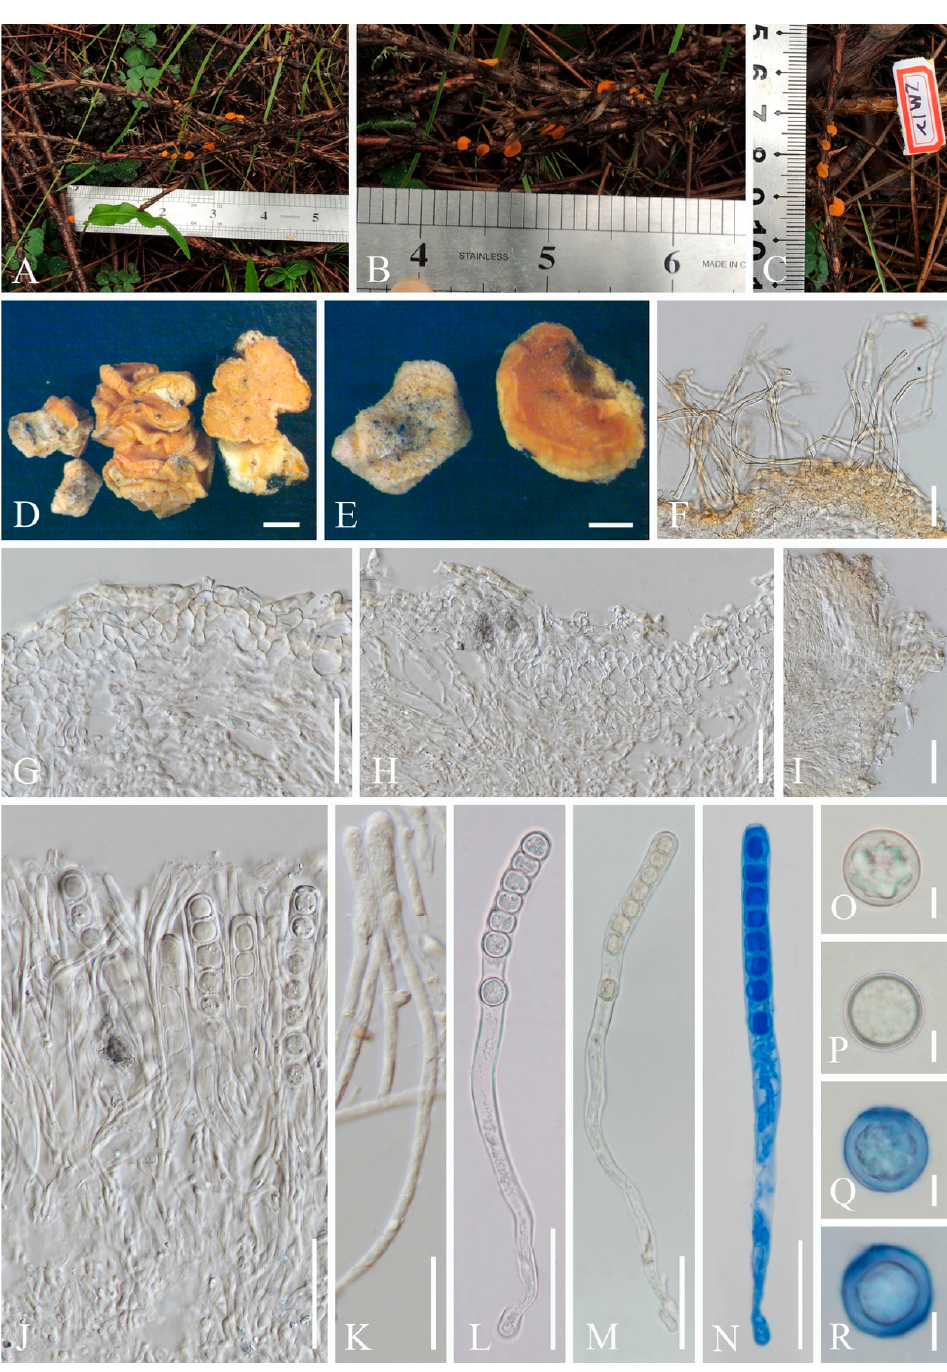
Figure 18. Pithya villosa (HKAS 104653, holotype). ( A – C ) Fresh specimens. ( D , E ) Dry specimens. ( F ) Hyphoid hairs on the surface of receptacle ectal excipulum. ( G , H , I ) Vertical section of receptacle ectal excipulum on the upper flank. ( J ) Hymenium. ( K ) Paraphyses. ( L – N ) Asci and ascospores [( N ) Ascus and ascospores in CB.] ( O – R ) Ascospores ( Q , R ) Ascospore in CB. Scale bars ( D ) = 1000 µ m; ( E ) = 500 µ m; ( F – J , L – N ) = 50 µ m; ( K ) = 20 µ m; ( O – R ) = 5 µ